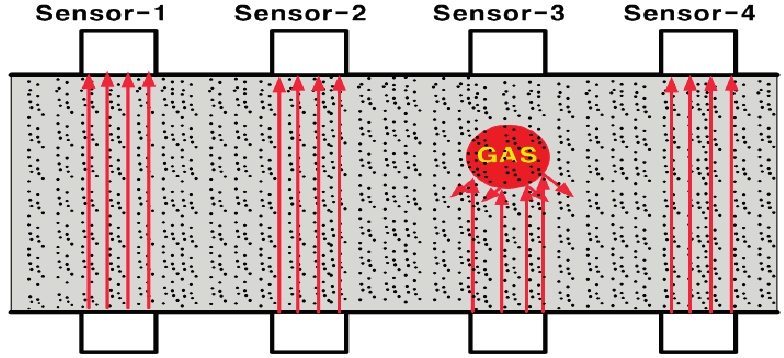
Figure 1. Example of sludge measurement distortion using an ultrasonic multi-beam